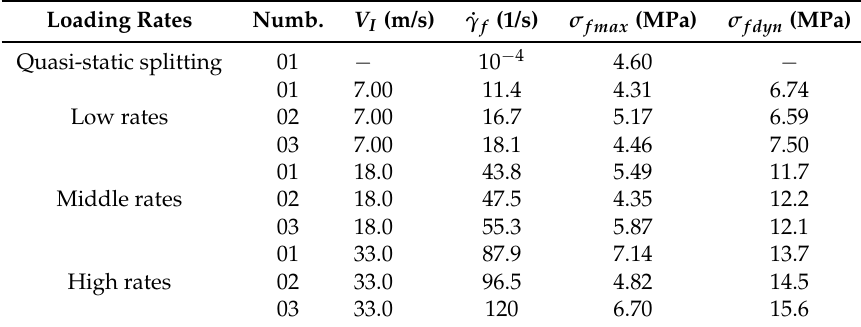
Table 2. Strain rates and tensile